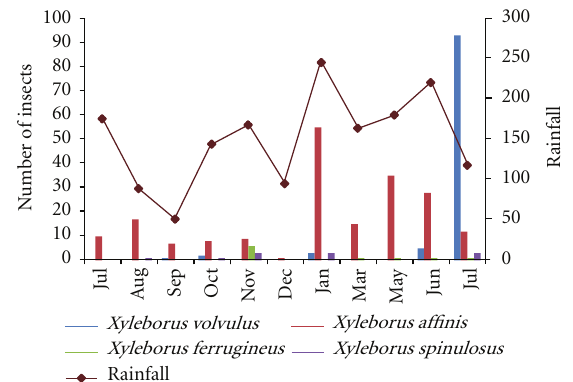
Figure 3: Monthly rainfall and total number of four of the most abundant species of Scolytinae subfamily collected with Escolit´ıdeo/Curitiba traps from July 2005 to July 2006, in primary forest of Central Amazon.